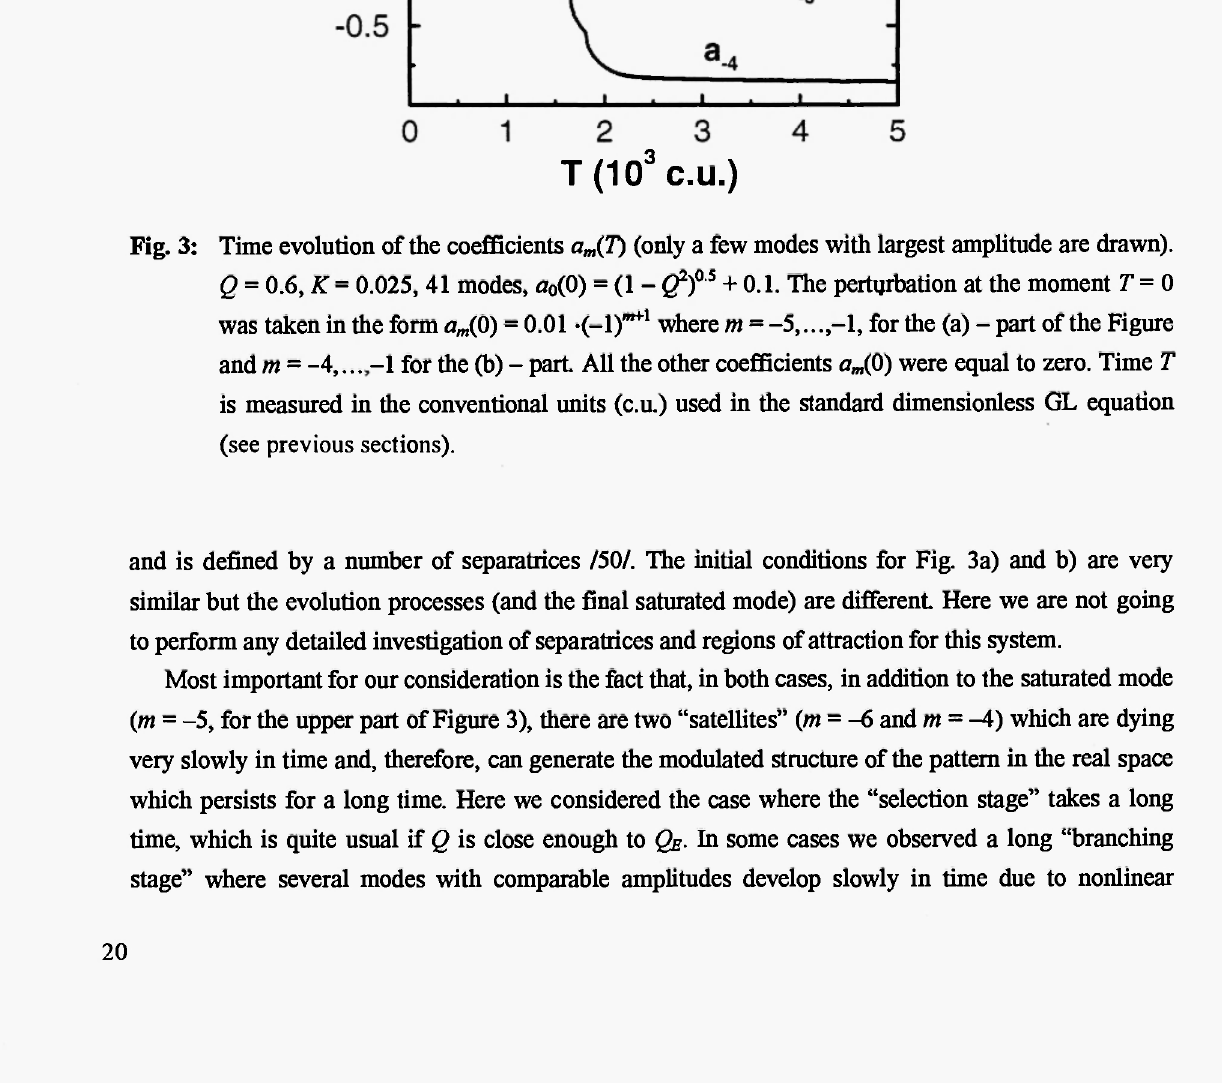
Fig. 3: Time evolution of the coefficients a (T) (only a few modes with largest amplitude are drawn). m Q = 0.6, Κ = 0.025, 41 modes, o (0) = (1 - β 2 ) 0 5 + 0.1. The perturbation at the moment Τ = 0 0 was taken in the form o (0) = 0.01 -(-l)"* 1 where m = -5 -1, for the (a) - part of the Figure m and m = -4....-1 for the (b) - part. All the other coefficients a (0) were equal to zero. Time Τ m is measured in the conventional units (c.u.) used in the standard dimensionless GL equation (see previous